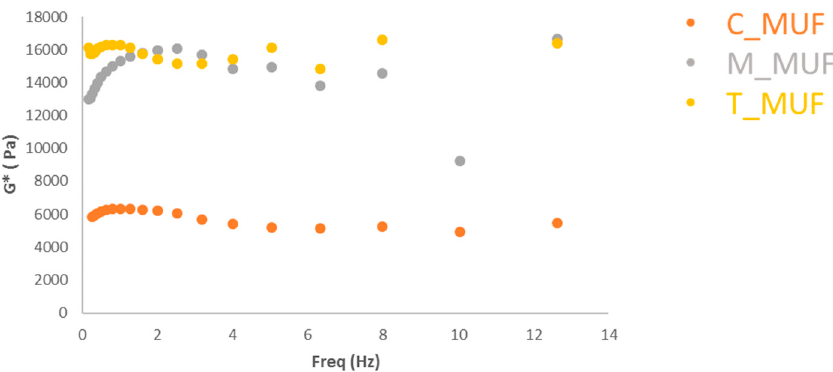
Figure 7. Frequency Sweep Test at 25 °C muffin. C_MUF = Muffin prepared by C_BP; M_MUF = Muffin